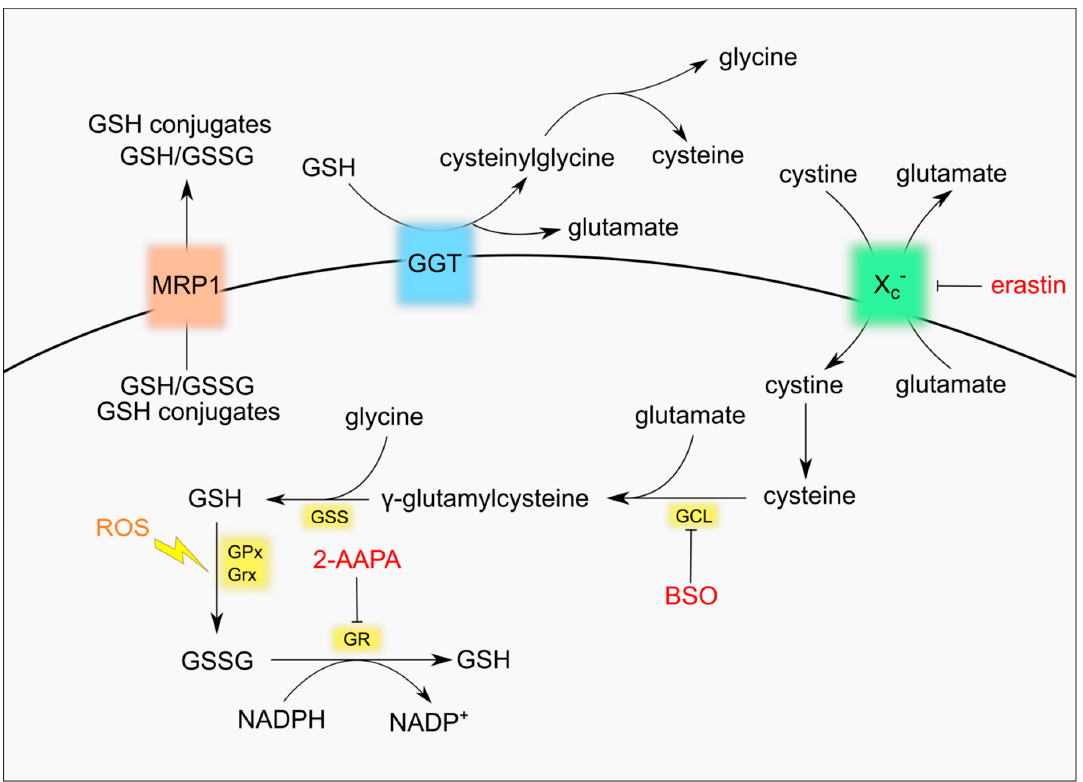
Figure 1. Glutathione (GSH) metabolism and druggable targets.